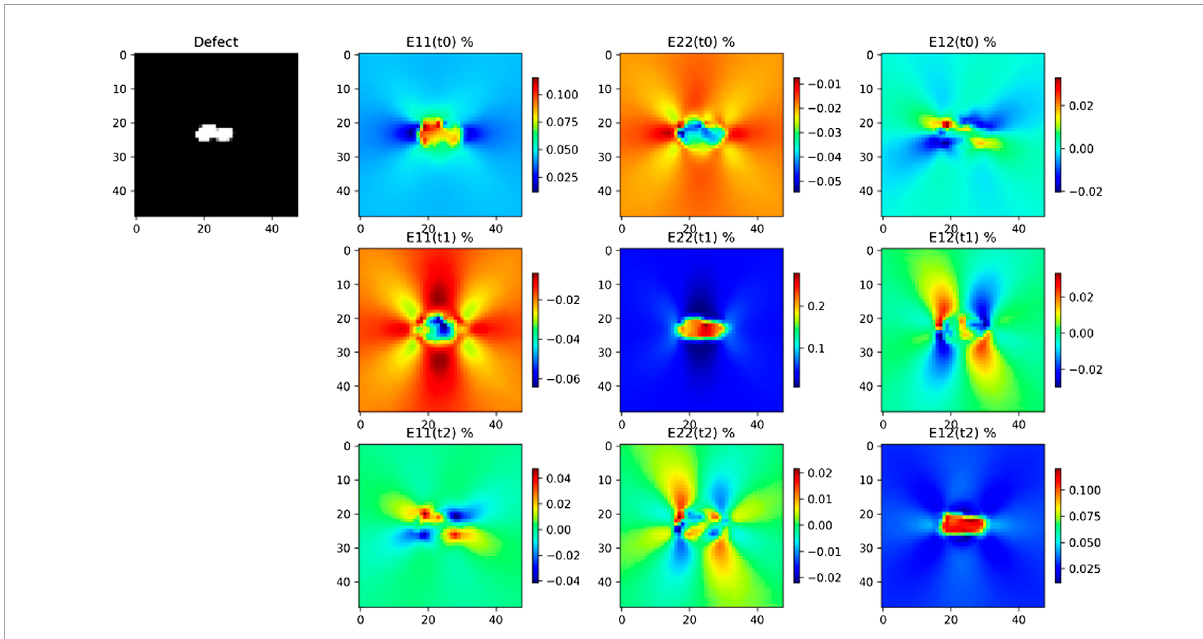
FIGURE 3 Multimodal data for digital twin i = 1, on the top left μ ( 1 ) □ ; on the right, the 3 components of the strain tensor ɛ ( u (1) ) at 3 time instants t 0, t 1, t 2.